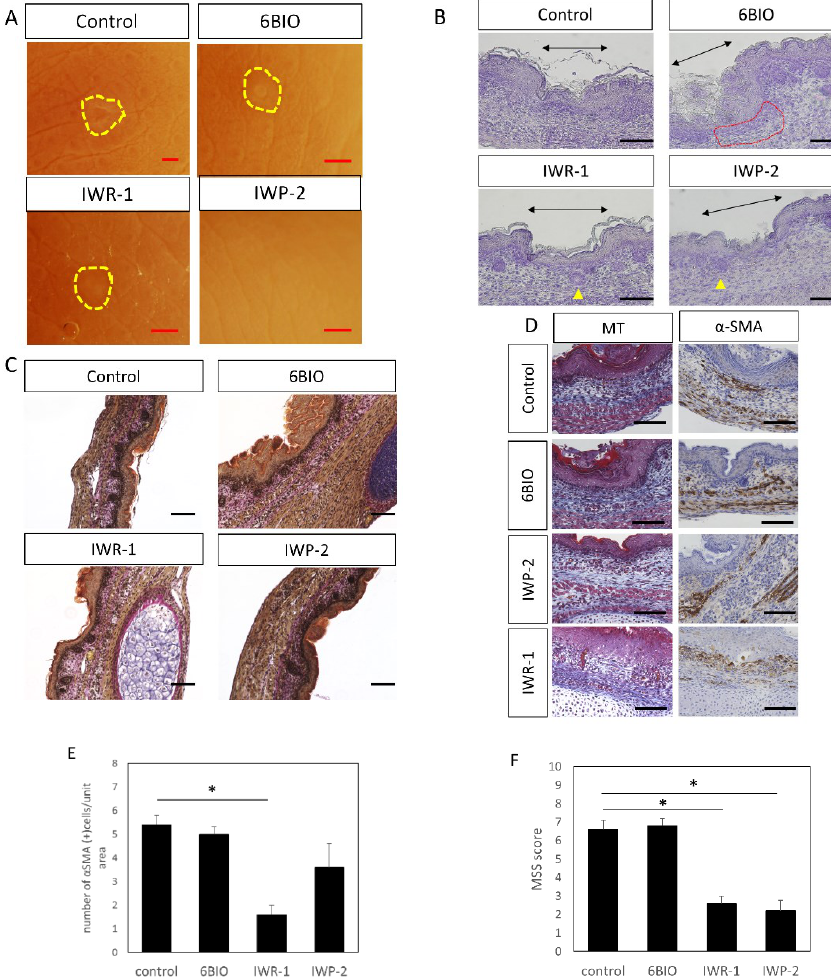
Figure 7. E15 scar healing by administration of Wnt enhancer/inhibitor. ( A ) Observation by stere- omicroscope. The scar is indicated by a yellow circle. Scars were not noticeable in the IWP-2 admin- istration group. Scale bar = 1 mm. ( B ) Hematoxylin staining, scale bar = 100 μm. Black arrow: area of the scar. Yellow triangle: follicular structures observed within the scar. Red dotted line: area of thinning of the dermal structure in the scar. ( C ) EVG staining, scale bar = 100 μm. ( D ) Masson- Trichrome and α -SMA staining, scale bar = 100 μm. ( E ) Cell counting of α -SMA positive cells in wound. ( F ) Relationship between Wnt enhancer/inhibitor administration and wound MSS. * p < 0.05.